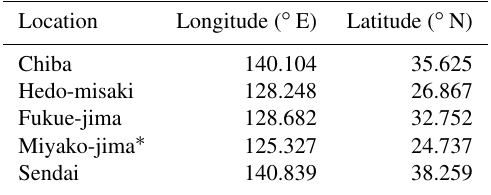
Table 1. SKYNET sites for surface observation